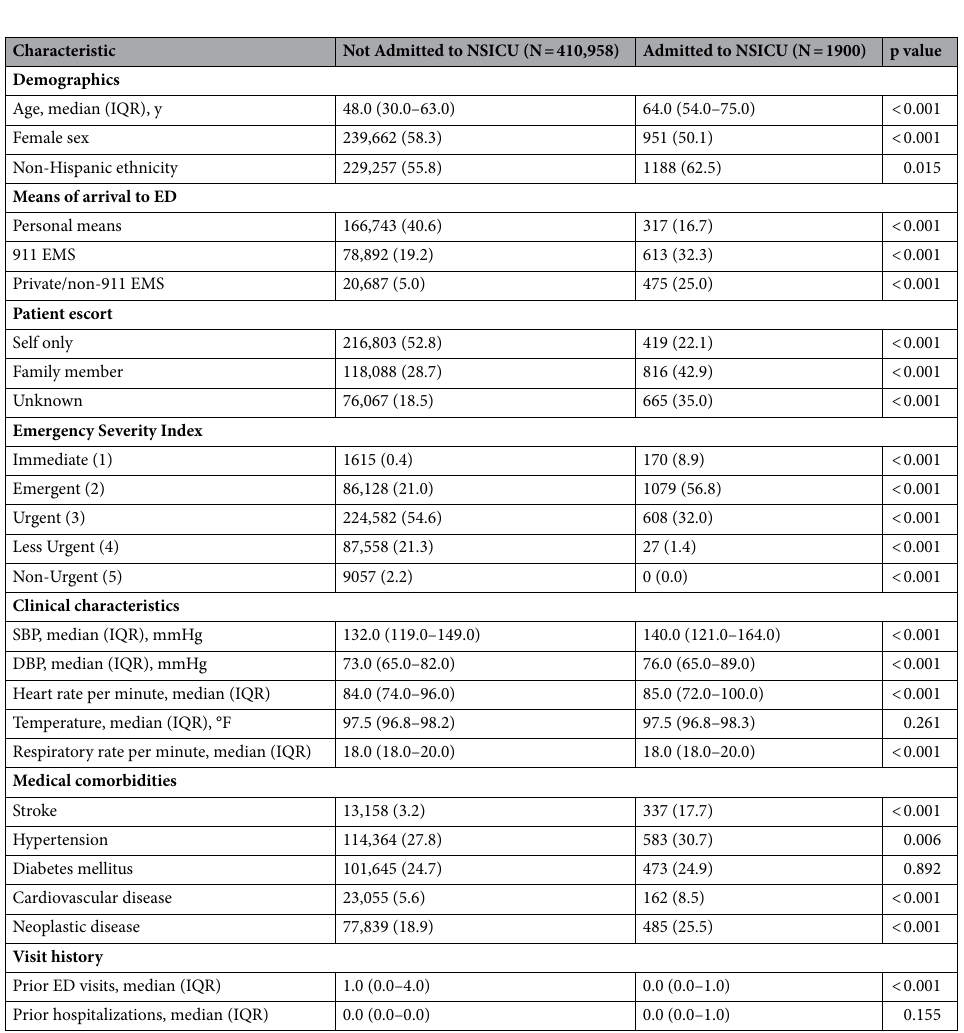
Table 1. Clinical and demographic characteristics of patient cohort, stratified by admission to the neurosciences intensive care unit (NSICU). All figures reported as numbers (%) unless otherwise specified. Patients not admitted to NSICU include patients admitted to non-NSICU services, discharged from ED, or died/transferred in/from ED. NSICU neurosciences intensive care unit, IQR interquartile range, SBP systolic blood pressure, DBP diastolic blood pressure, ED emergency department, EMS emergency medical